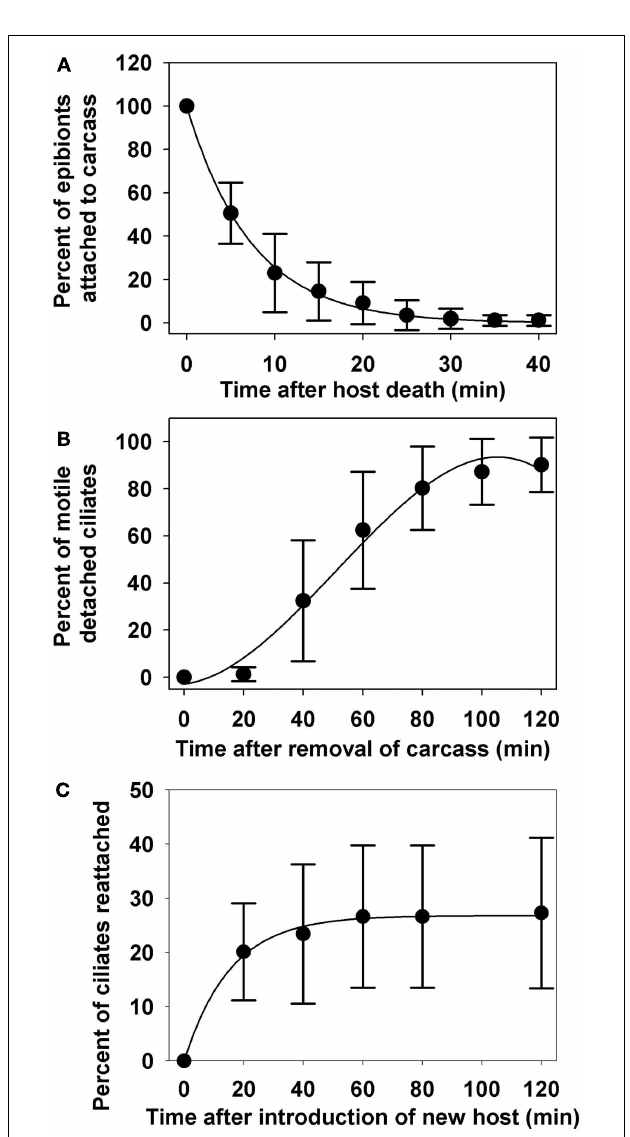
FIGURE 5 | Percentage of epibionts remaining on zooplankton host, E. gracilis after host death (A), motility of epibionts detached from copepod carcasses (B), and re-attachment of free-swimming ciliates to new copepod hosts (C). All data points are mean values ± SD ( n = 10).